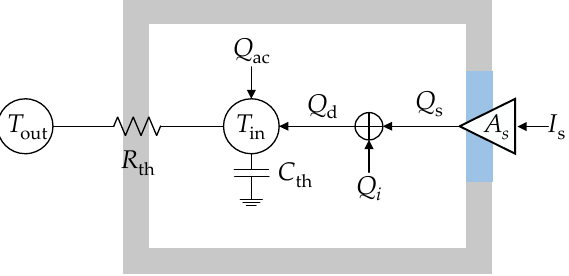
Figure 1. First-order equivalent thermal parameters circuit diagram.